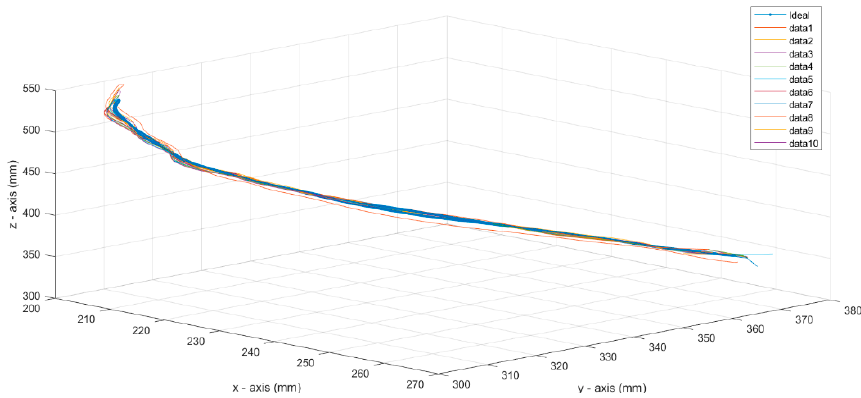
Figure 8. Trajectories of shoulder flexion–extension—load 2.2 kg.